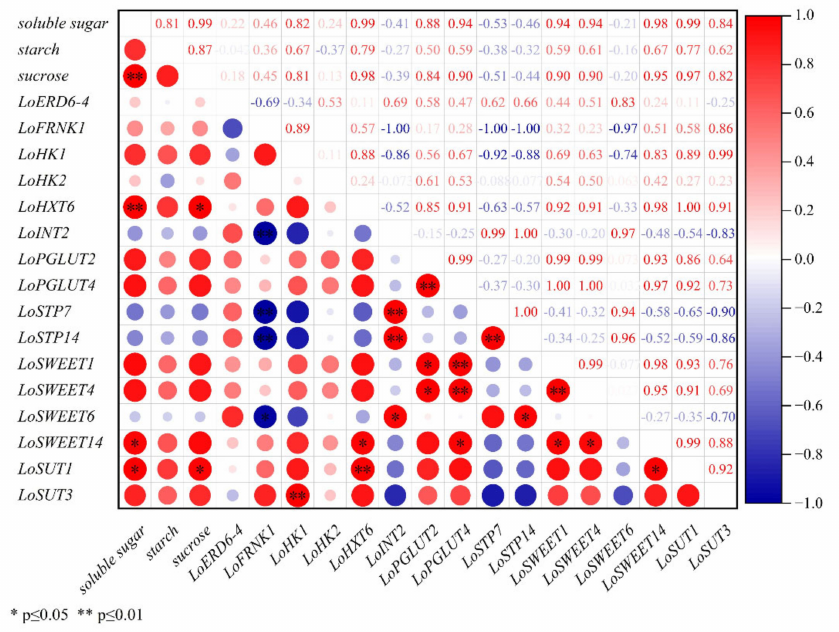
Figure 8. Correlation plot between sugar content and expression levels of ST genes during assimilates transport in